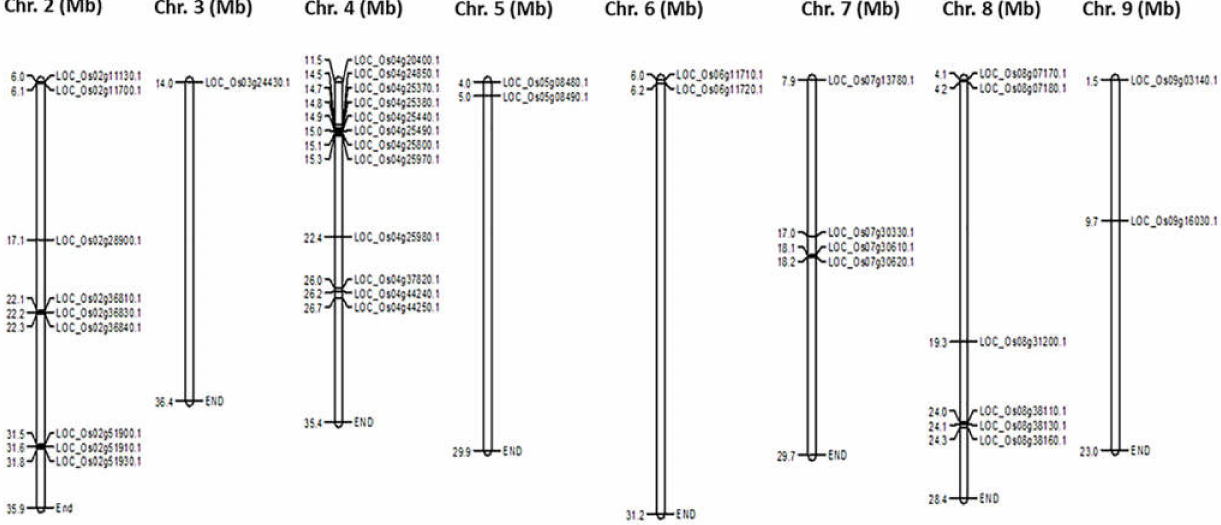
Figure 2. Graphical representation of physical locations of the cytokinin-O-glucosyltransferase (CGT) genes on rice chromosomes 2–10. Only tandem-duplicated genes on a particular chromosome are indicated in clusters. The chromosomal distances are given in